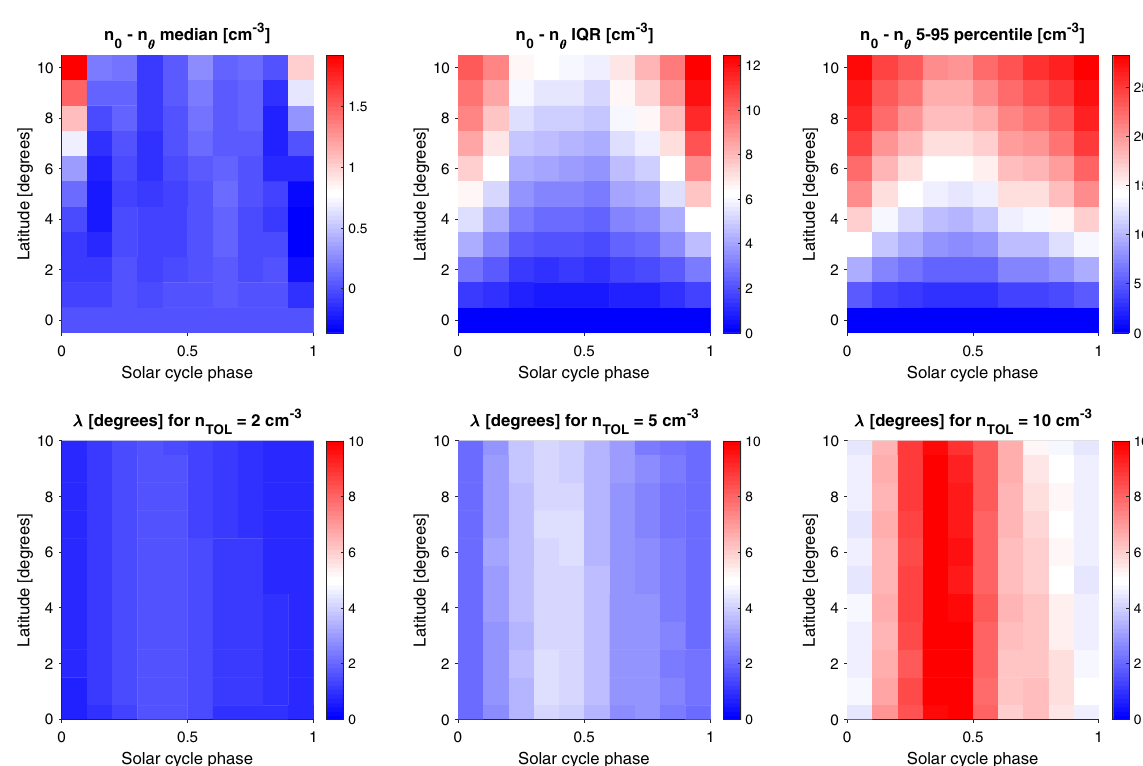
Fig. 12. Summary plots for the proton number density, n , in the same format as Figure 9.